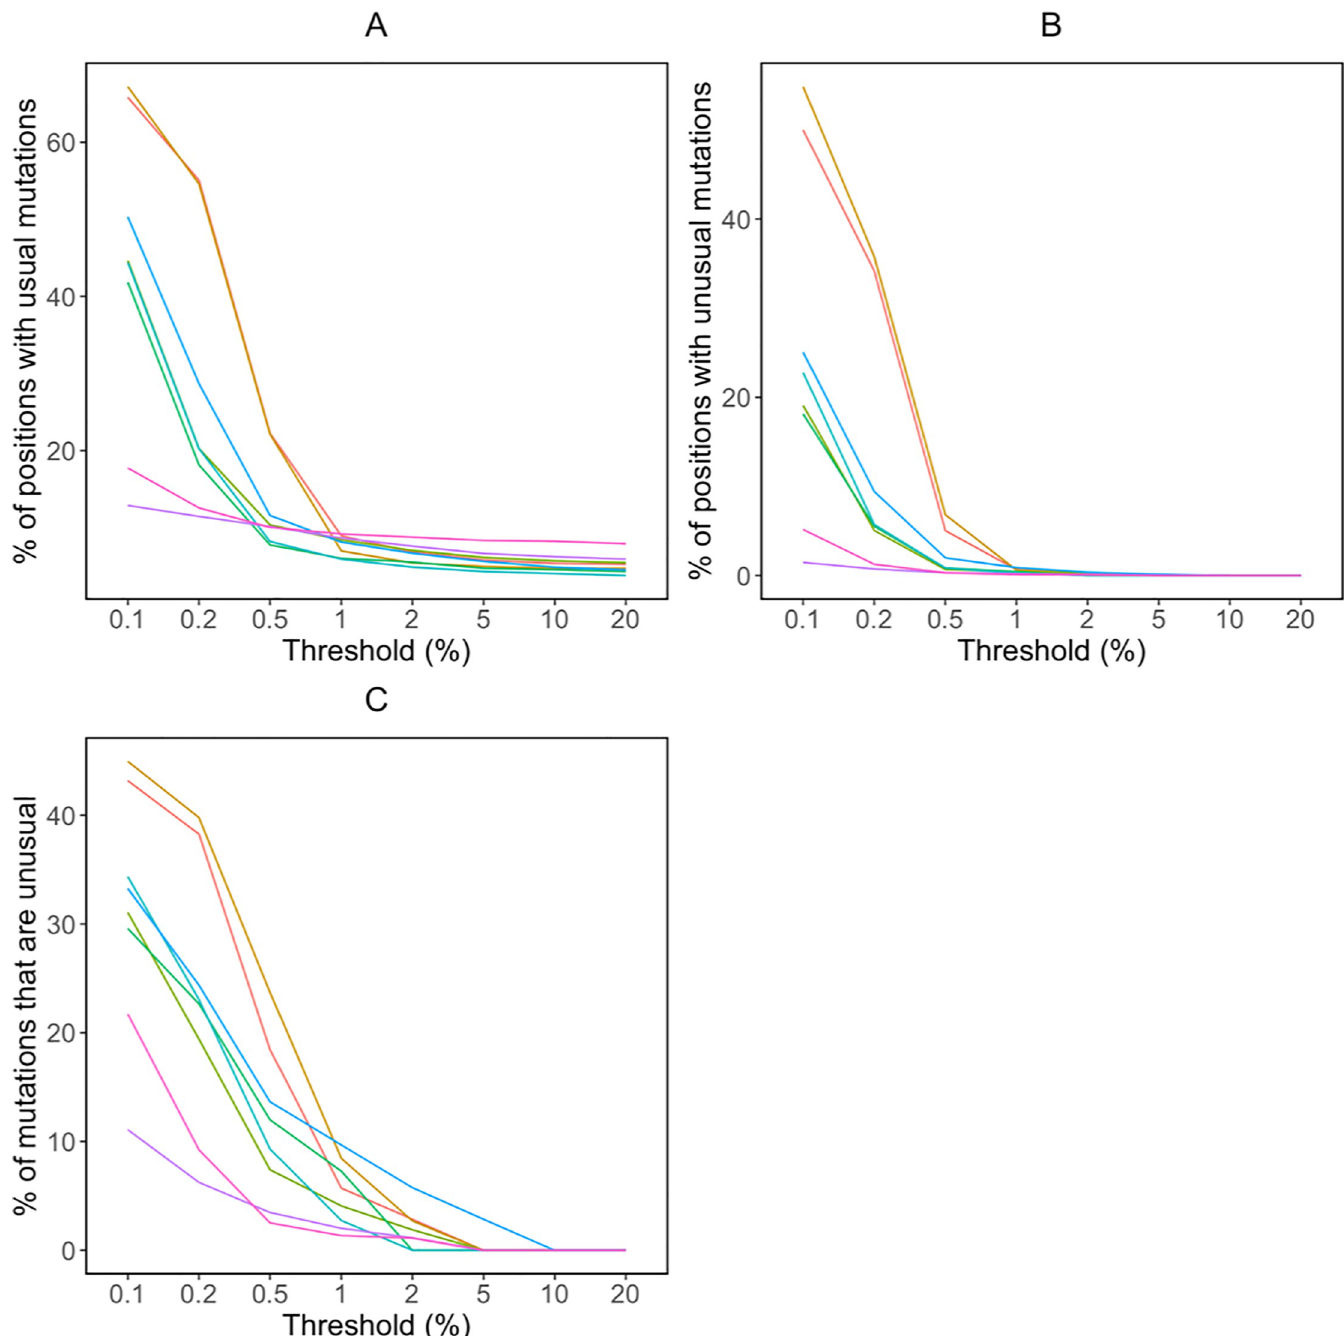
Fig 3. Median proportions of positions with usual mutations (A), proportions of positions with unusual mutations (B), and proportions of mutations that were unusual (number of unusual mutations / [number of usual mutations + number of unusual mutations]) (C) at eight NGS mutation detection thresholds for the pooled 855 samples in eight published datasets: light red (#FF6C67) [23], gold (#D79400) [19], lime green (#6CB100) [24], jade (#00C25C) [20], egg blue (#00C3C6) [25], sky blue (#00ABFF) [18], purple (#D475FF) [21], rose (#FF4ED1)